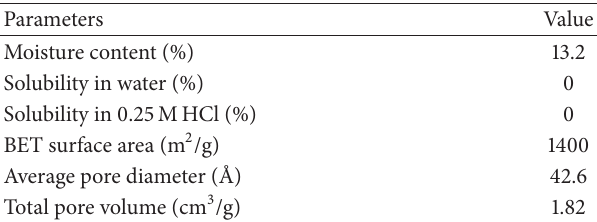
Table 1: Characteristics of the